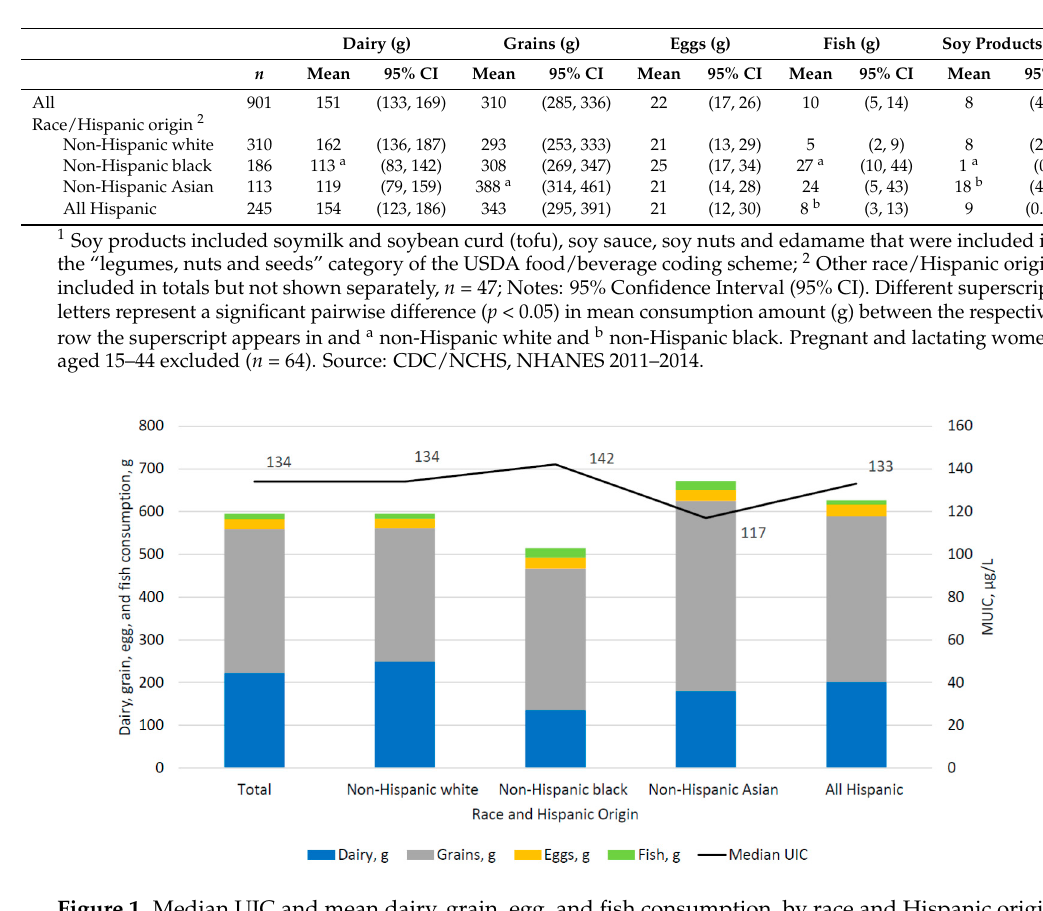
Table 4. Mean consumption of dairy, grains, eggs, fish, and soy products among women aged